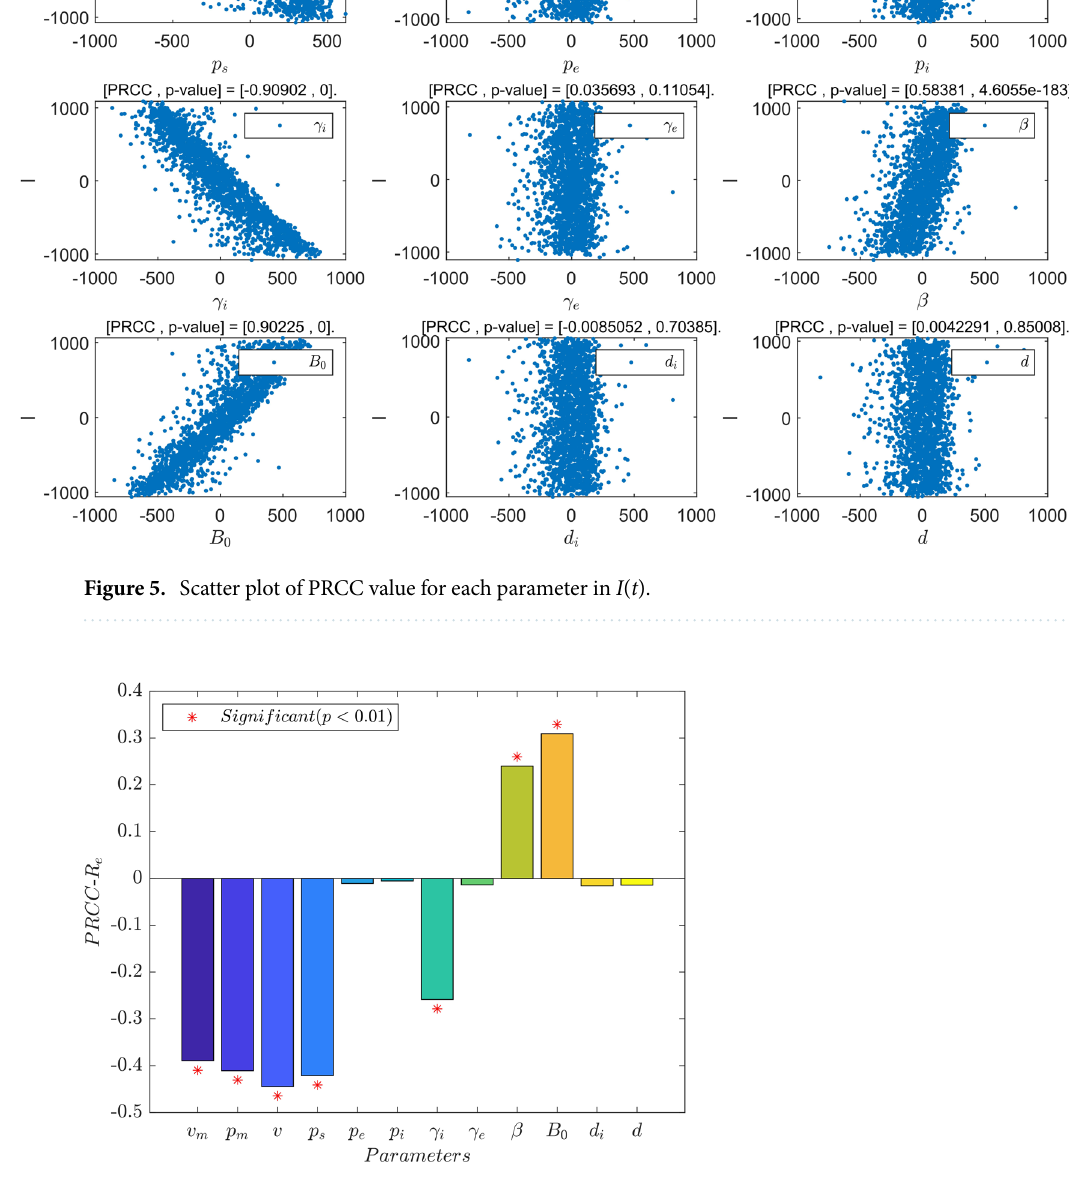
Figure 6. The PRCC value of the parameter to R e